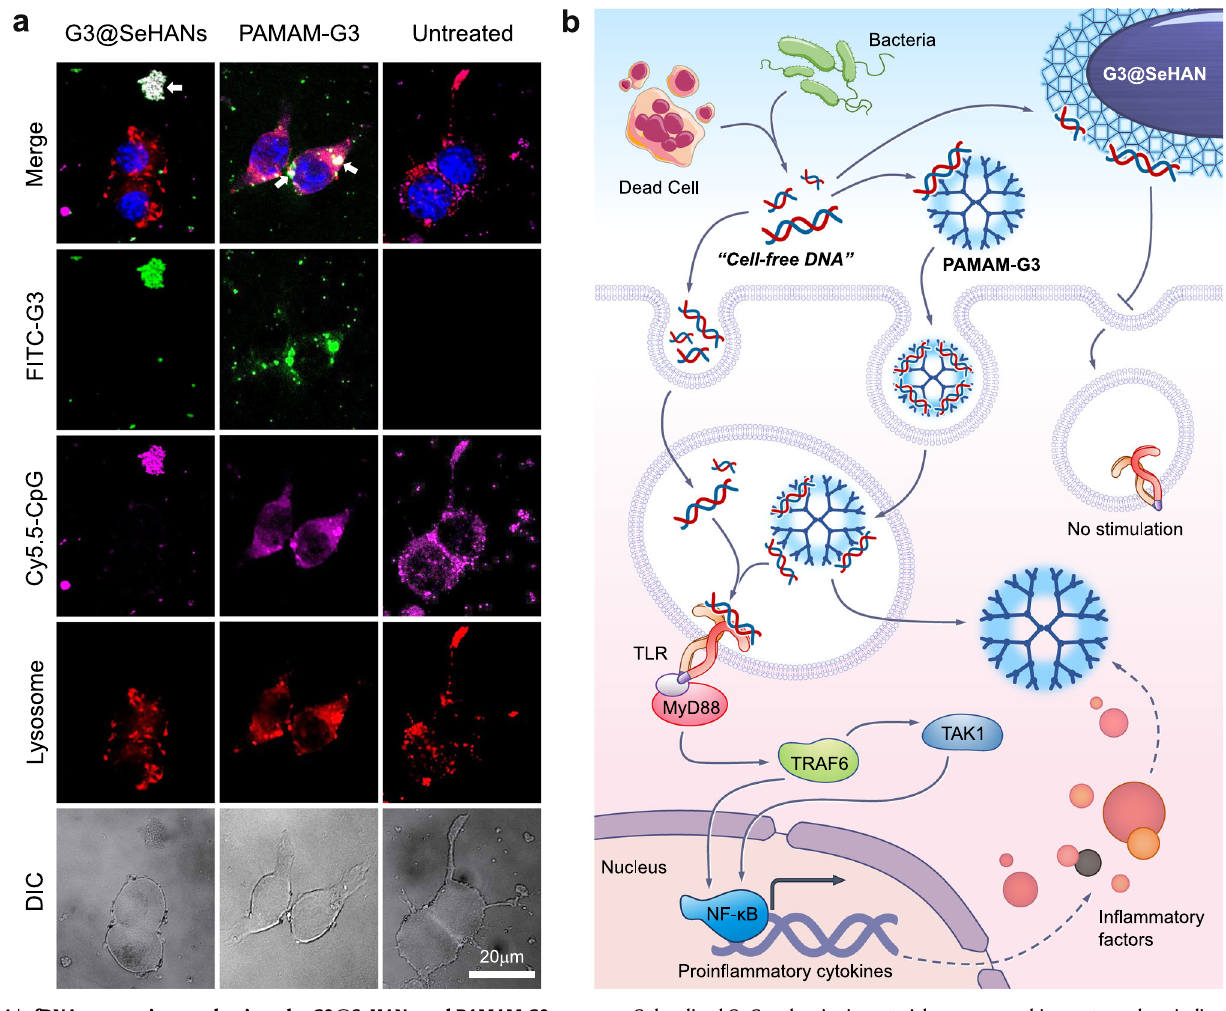
Fig. 4 | cfDNA-scavenging mechanisms by G3@SeHANs and PAMAM-G3. a Enlarged images show intracellular localization of CpG oligonucletides and cationic materials in RAW 264.7 cells after a 12h incubation. Scale bar, 20 μ